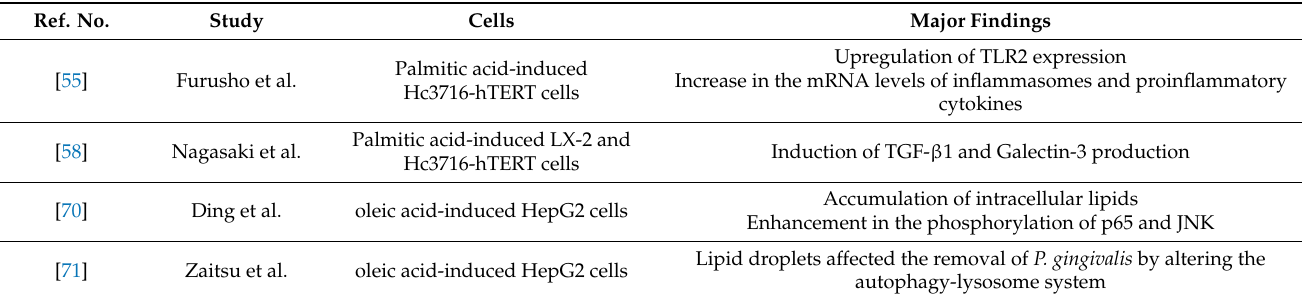
Table 6. In vitro basic research regarding the relationship between NAFLD and periodontal disease. Ref. No. Study Cells Major Findings Upregulation of TLR2 expression Palmitic acid-induced Furusho et al. Increase in the mRNA levels of inflammasomes and proinflammatory Hc3716-hTERT cells cytokines Palmitic acid-induced LX-2 and Induction of TGF- β 1 and Galectin-3 production Hc3716-hTERT cells Accumulation of intracellular lipids oleic acid-induced HepG2 cells Enhancement in the phosphorylation of p65 and JNK Zaitsu et al. oleic acid-induced HepG2